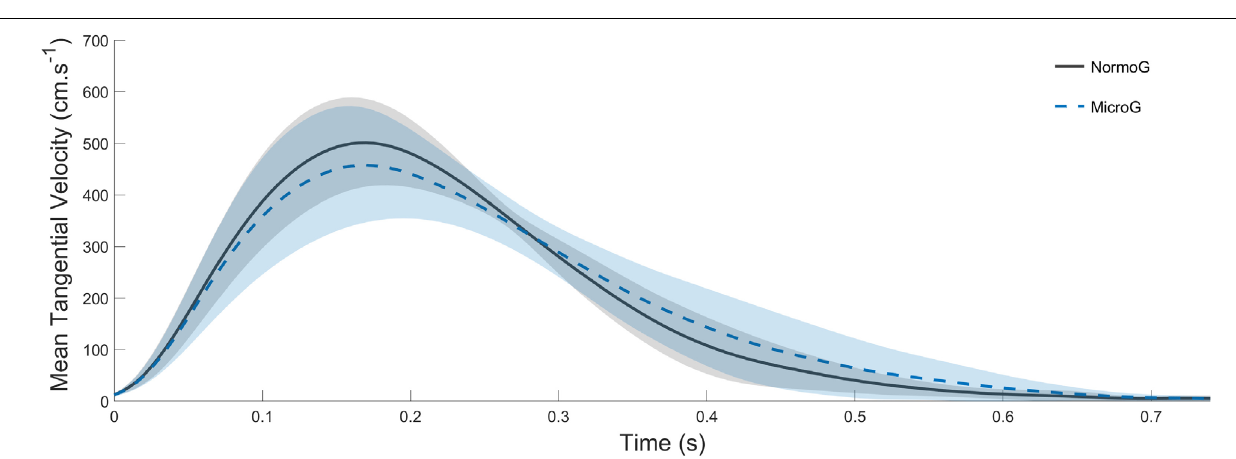
FIGURE 3 | Average endpoint tangential velocity recorded in T jump trials in both normo- (solid line) and microgravity (dotted line). Shaded areas represent between-subject standard